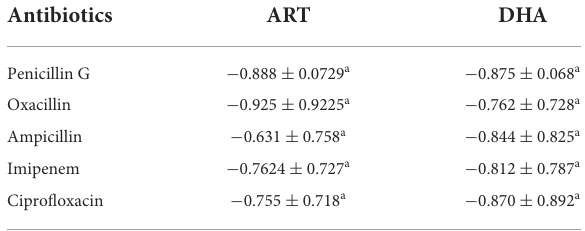
TABLE 4 Comparative unit (means ± SD) change in minimum inhibitory concentration ( µ g/ml) of antibiotics used in combination with ART and DHA.